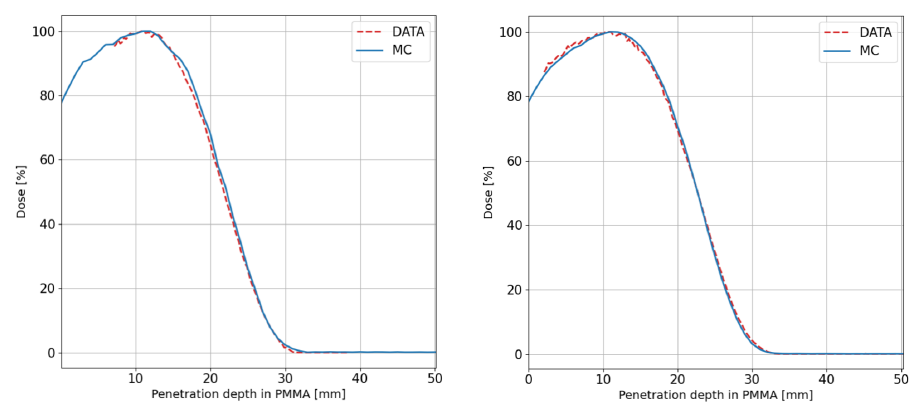
Figure 7. Measured (dotted red line) and simulated (continuous blue line) PDD in PMMA phantom obtained for the 7 MeV electrons beam collimated with the A-d30 ( left ) and A-d120 ( right ) applicators.